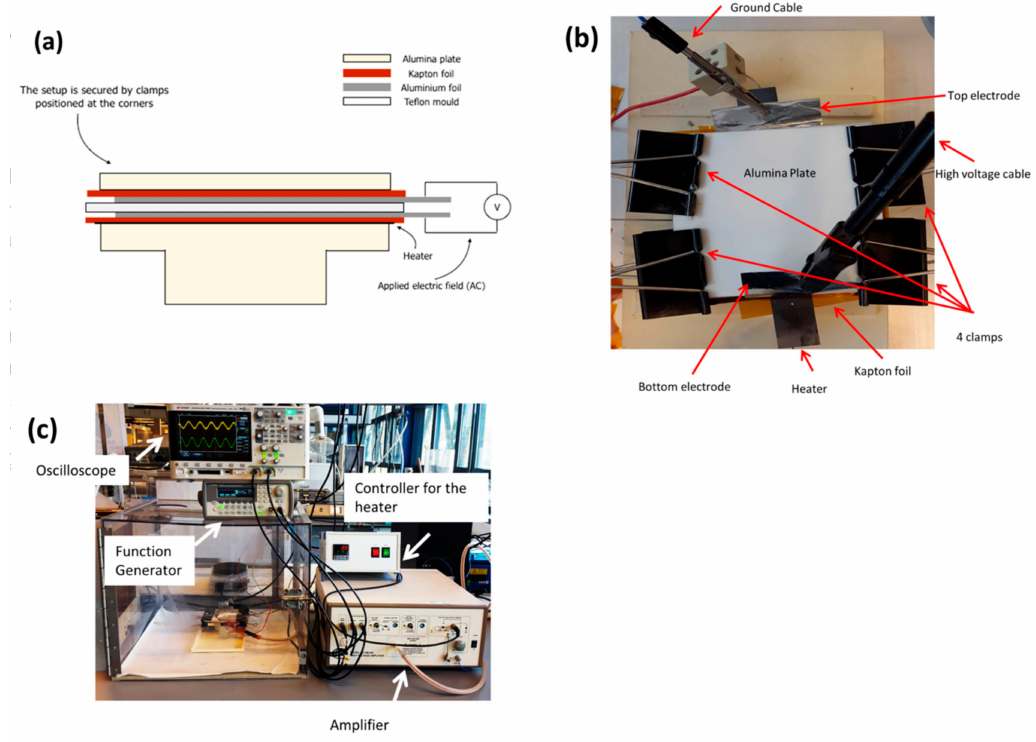
Figure 1. ( a ) Schematic of the mold and heater; ( b ) close-up view of the mold assembly; and ( c ) complete